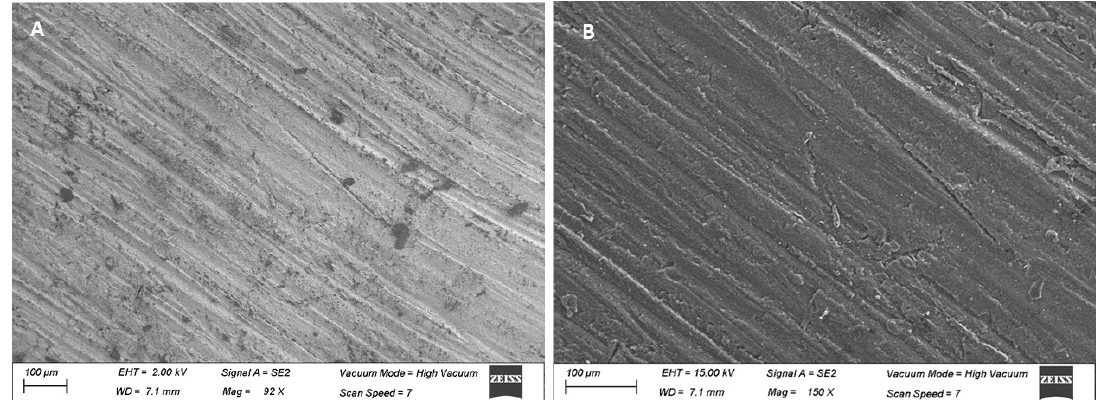
Figure 1. ( A ) Polymethyl methacrylate (PMMA) disk. ( B ) Graphene doped (GD)-PMMA. Streaks imparted by the milling were present at low magnification.